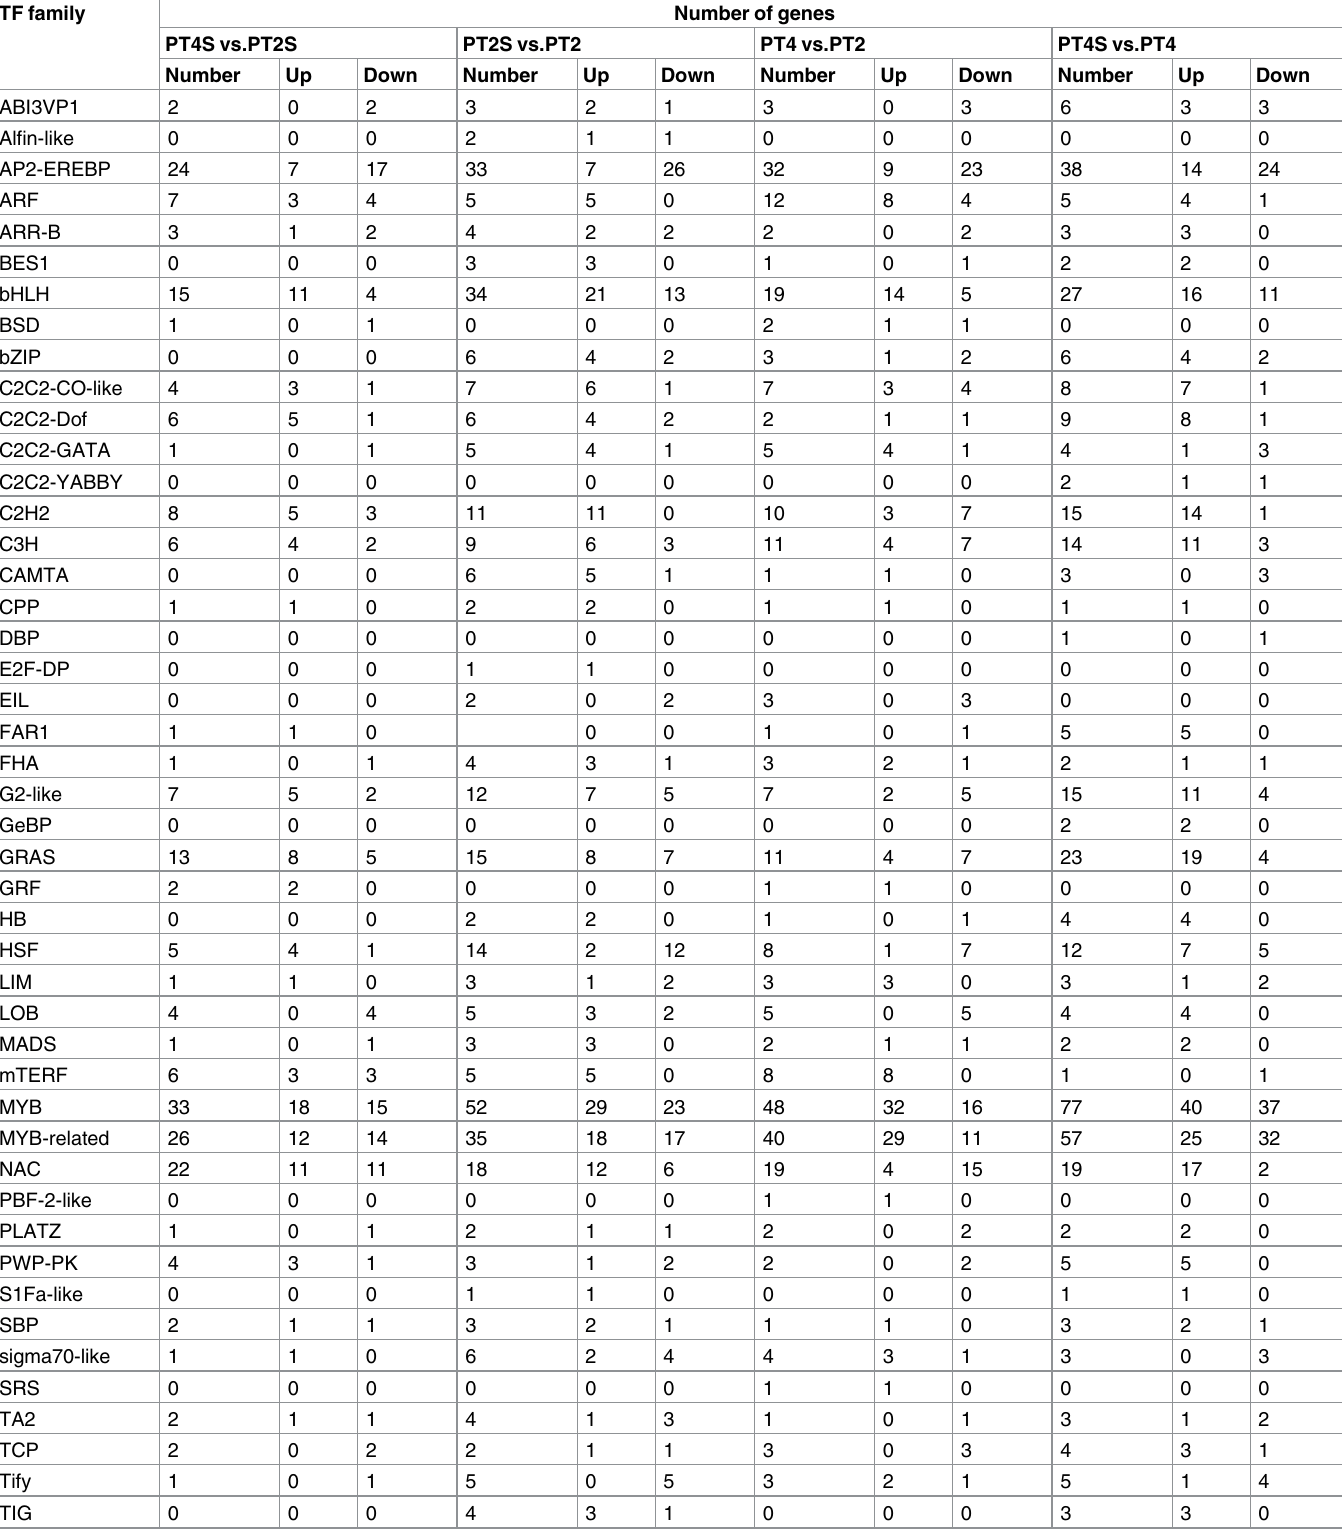
Table 3. The number of DEGs in transcription factor families in response to salt stresstreatments. TF